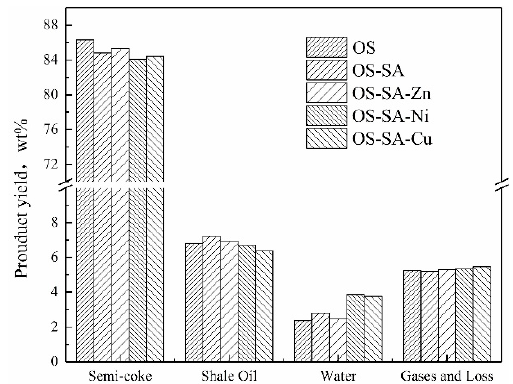
Figure 5. Effects of SA and its supported transition metal salts on the yield of OS pyrolysis products.